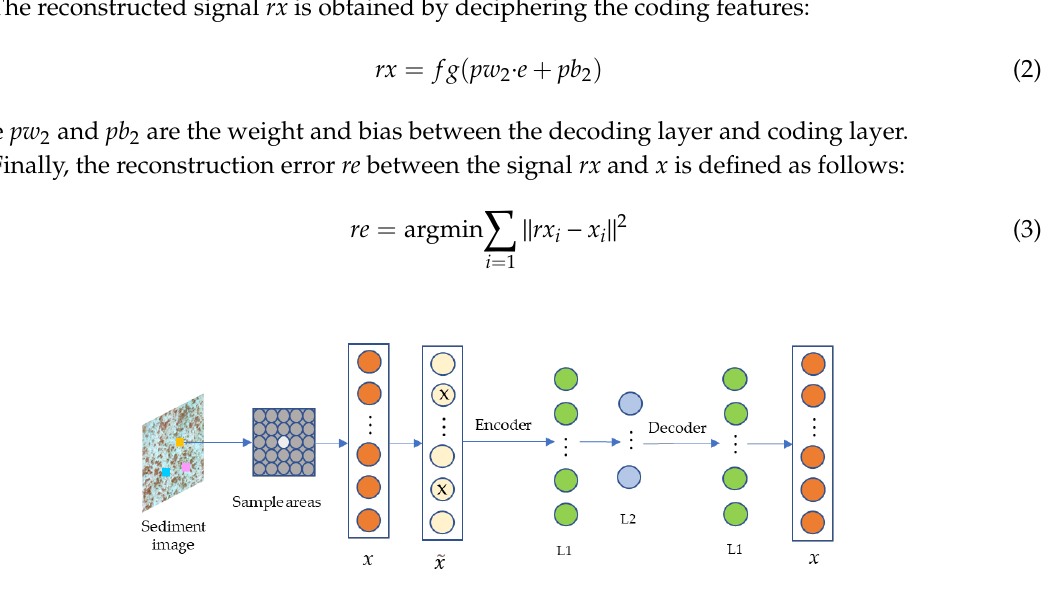
Figure 2. Feature extraction process of the stacked denoising auto encoder (SDAE).